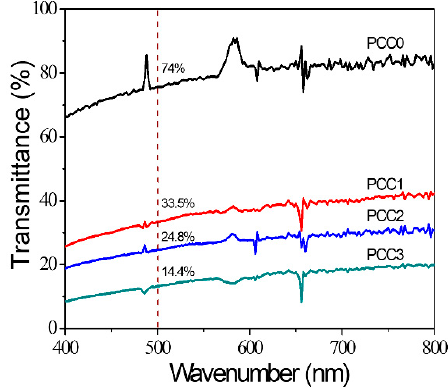
Figure 4. Optical transparency of PCC hydrogels.